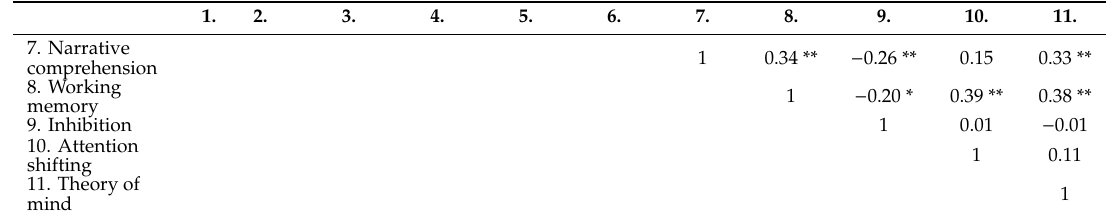
Table 4. Results of the hierarchical regression analyses on receptive vocabulary (PPVT—R). R 2 = 0.78. Models